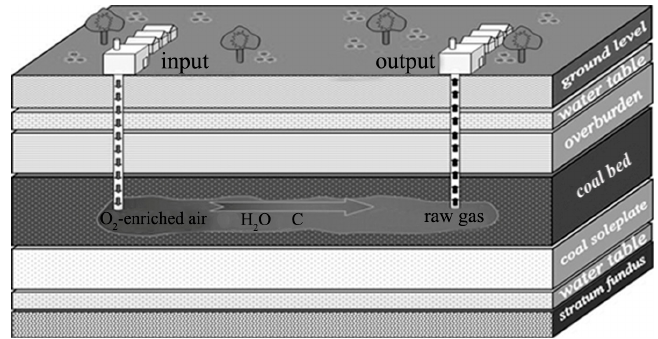
Figure 1. Sketch of the underground coal gasification (UCG) process.